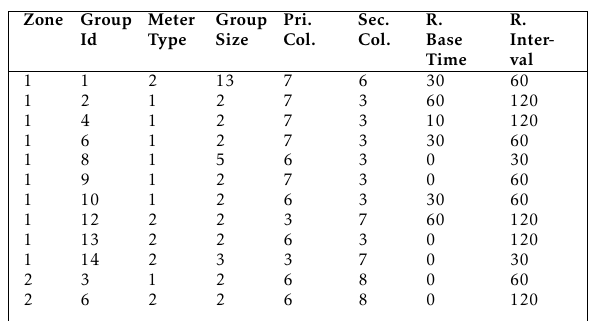
Table 4. Output: Meters’ Configurations